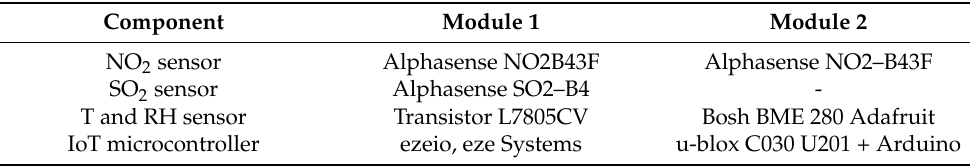
Table 1. Main components of the integrated air quality